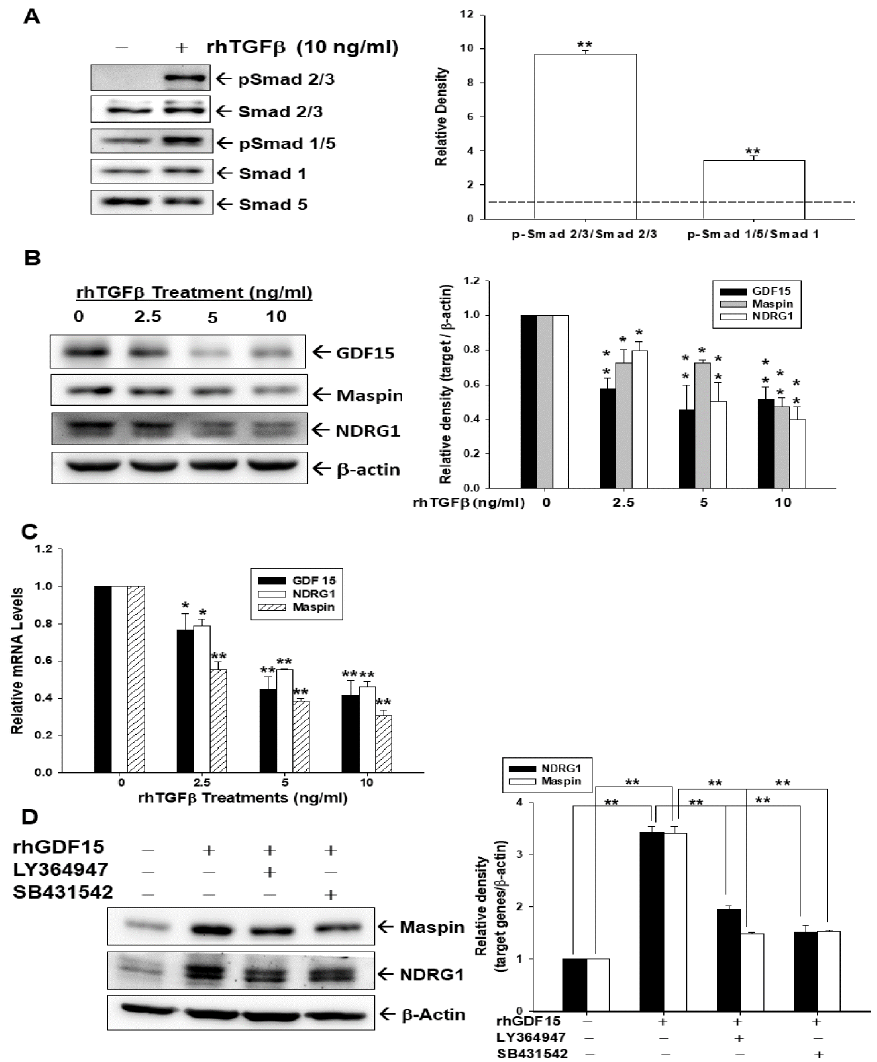
Figure 1. TGF β downregulates expressions of GDF15, maspin and NDRG1 is dependent on TGF β /Smad signaling in bladder carcinoma cells. The expressions of Smad 2/3, p-Smad 2/3, Smad 1, Smad 5, and p-Smad 1/5 were determined using immunoblot assays (( A ), left) and quantitative analysis (( A ), right) after treated with (+) or without ( − ) 10 ng/mL rhTGF β for 1 h in HT1376 cells. The expressions of GDF15, maspin, NDRG1, and β -actin were determined using immunoblot assays (( B ), left) and quantitative analysis (( B ), right) after being treated with various concentrations of rhTGF β as indicated for 18 h in HT1376 cells. ( C ) HT1376 cells were treated with various concentrations of rhTGF β as indicated for 18 h. The relative mRNA levels of GDF15, NDRG1, and maspin were determined by RT-qPCR assays. ( D ) The expressions of maspin, NDRG1, and β -actin were determined using immunoblot assays (( D ), left) and quantitative analysis (( D ), right) after being treated with 400 ng/mL rhGDF15, 20 μ M LY364947, and 20 μ M SB431542 as indicated for 18 h. The quantitative data were expressed as the intensity of protein bands of the target genes/ β -actin relative to the control solvent-treated group ( n = 3). * p < 0.05, ** p <